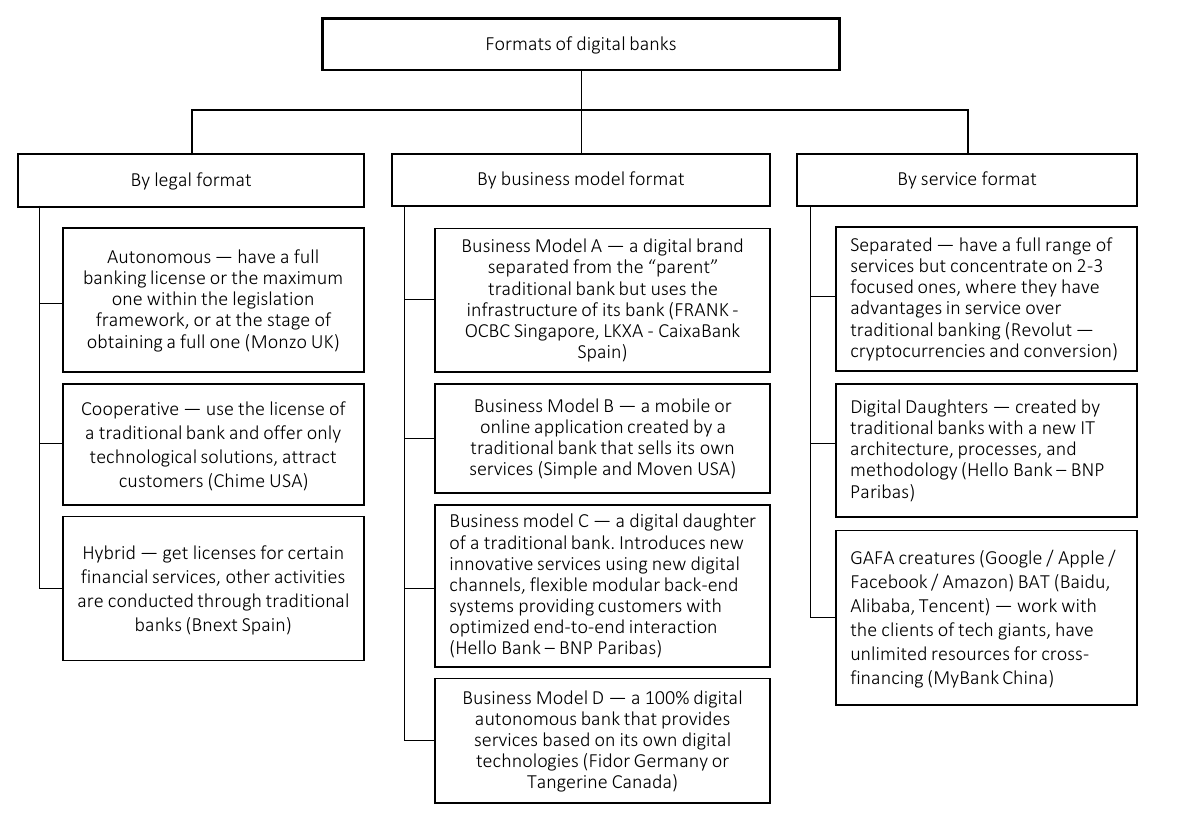
Figure 5. Classification of digital